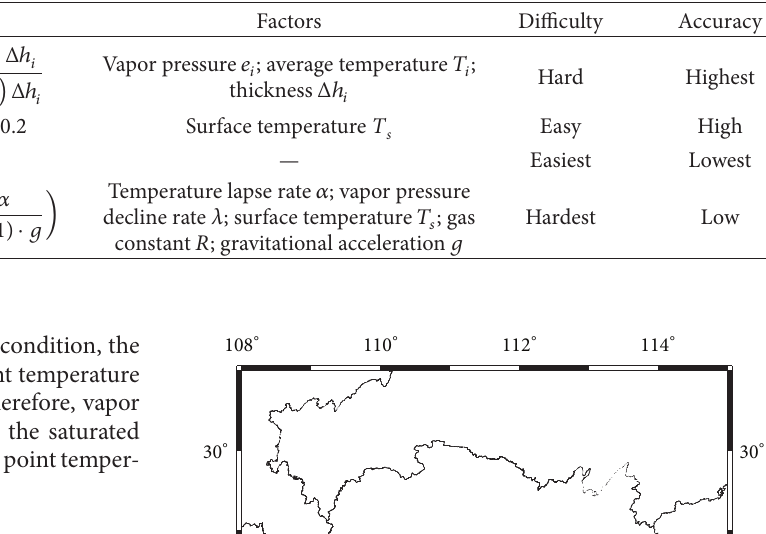
Table 1: Comparison of four typical methods for obtaining 𝑇 𝑚 .